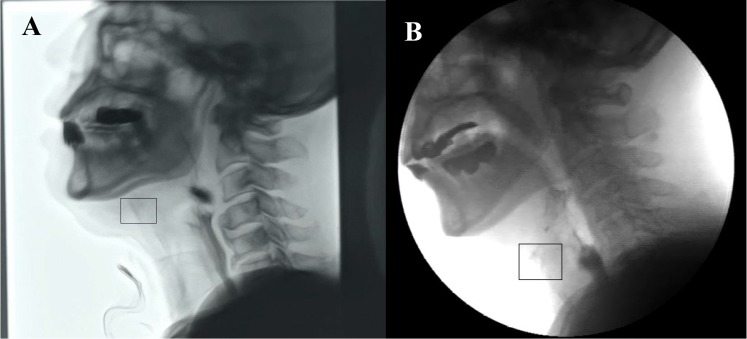
Example of unrecognizable hyoid bone located in the square in black.A. The hyoid bone moves too fast, resulting in the almost equal grey scale value in the area around it. B. The strong reflective light makes the hyoid bone invisible.